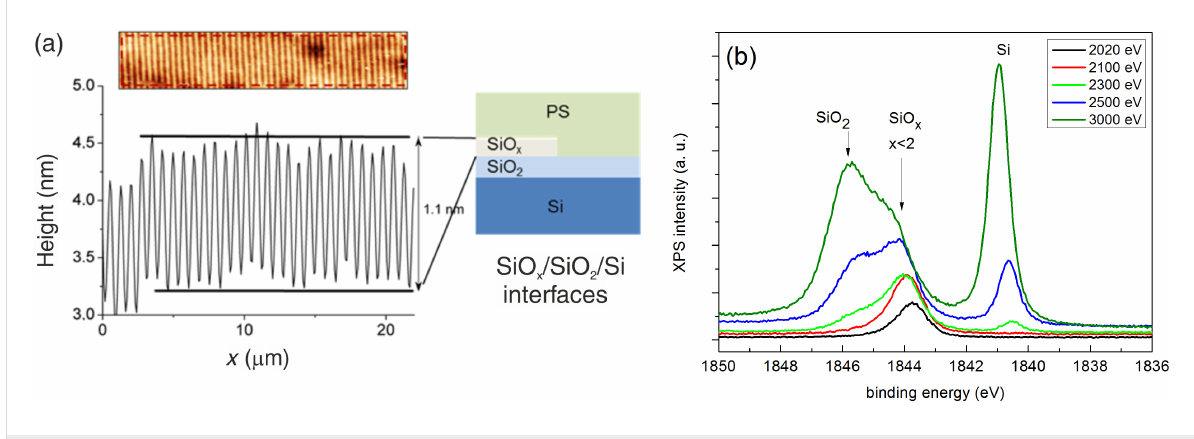
Figure 7: (a) AFM topography image and profile of the PS–OH brush annealed and cooled down in nitrogen after parallel oxidation nanolithography. A scheme is included showing the different regions. (b) HAXPES spectra of the Si 1s region at different photon energies.